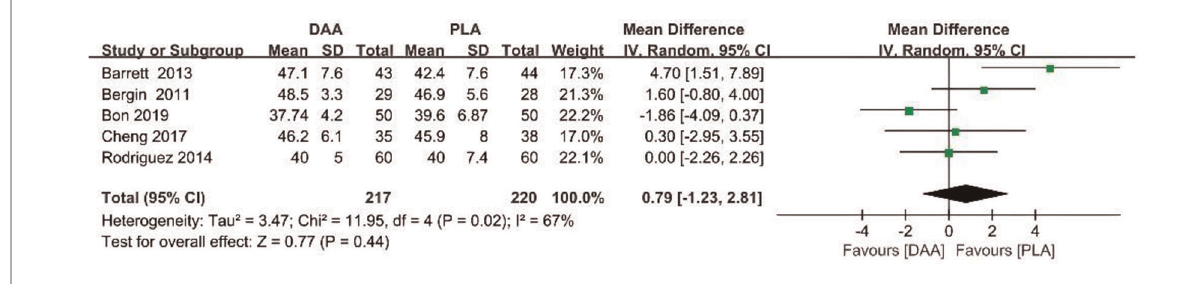
FIGURE 9 Acetabular abduction outcome forest plot analyses.